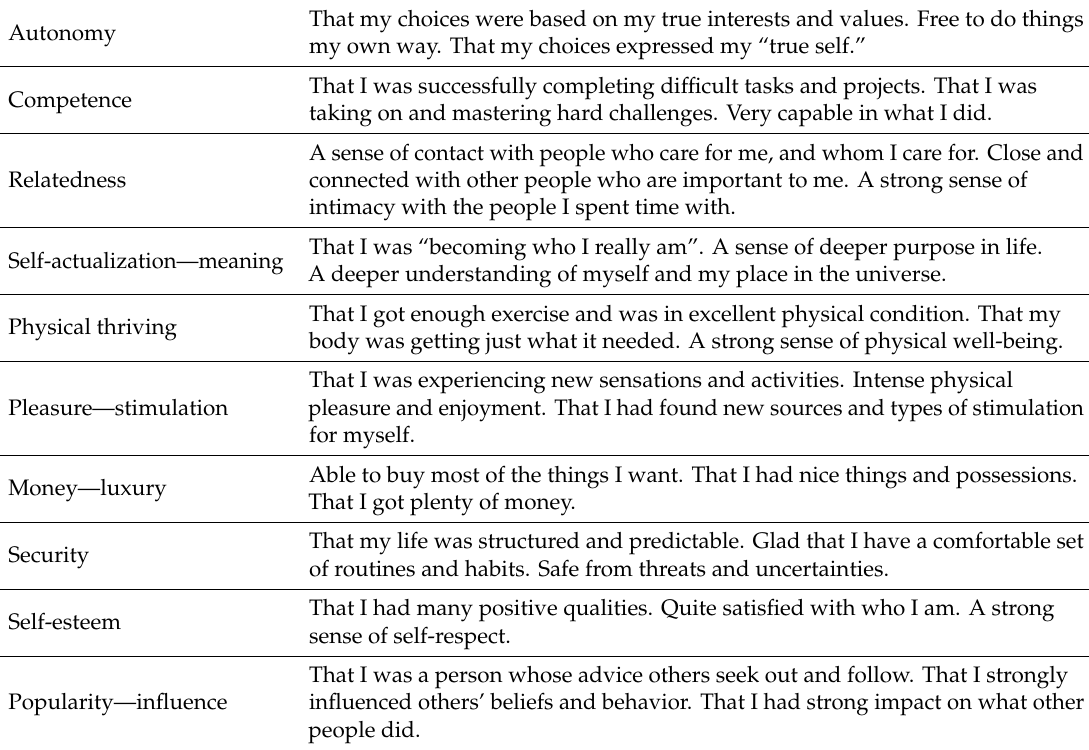
Table 2. Ten universal psychological needs [15] (p.